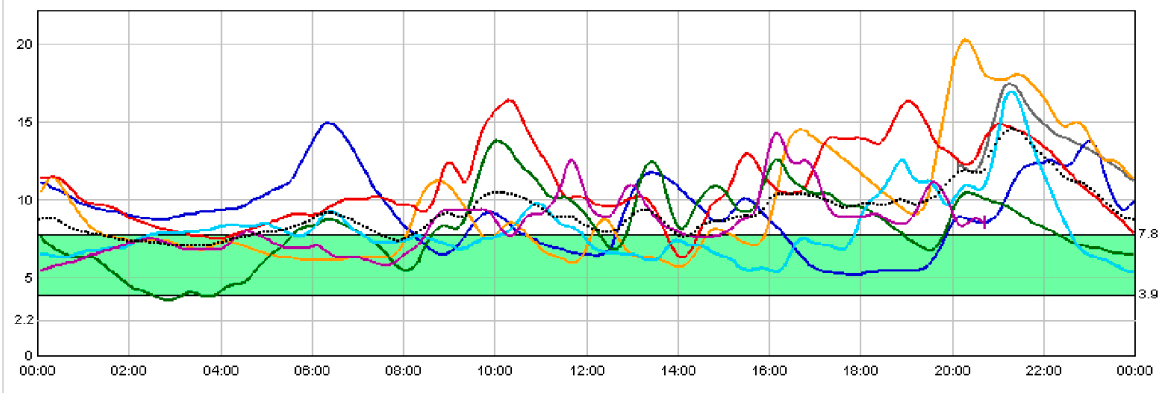
Figure 1: Continuous monitoring of blood glucose (mmol/l) with multiple-dose insulin injections and prandial insulin administered 15 minutes after the start of meals. Solid lines represent the record of six individuals and consecutive days. The dotted line is the average of the six recorded days. The shaded zone represents the target glucose value.